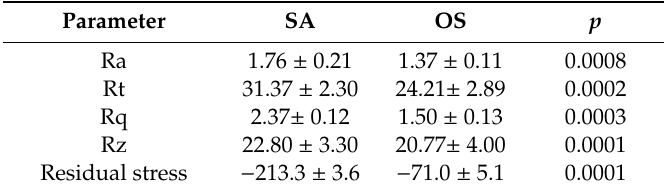
Table 1. Surface profile parameters ( μ m) and residual stress ( σ) in MPa. 97